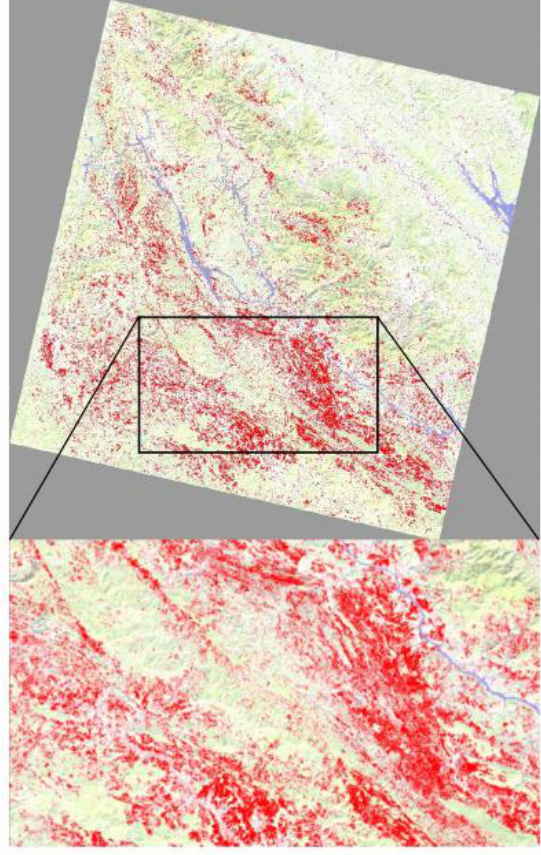
Figure 5. Cropland map of the study area and window for detail visualization. Cropland is coloured in red and displayed over blurred background made by Landsat 8 colour composite RGB: 654